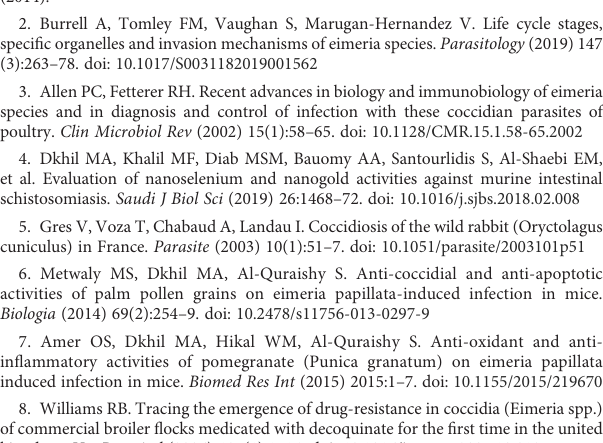
SUPPLEMENTARY FIGURE 1 Oocyst output in mice infected with Eimeria papillata and for infected treated groups with 0.25 mg/kg, 0.5 mg/kg, 1 mg/kg Bio-SeNPs, and 120 mg/kg amprolium (AMP) on day 5 p.i. All values are means ± SD. * signi fi cance (P ≤ 0.05) between infected and treated